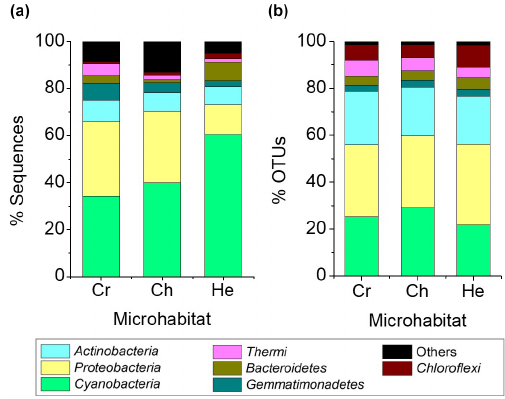
Figure 4. Average relative abundance of sequence reads (a) and OTUs at the 97% clustering cut-off (b) of major bacterial phyla (at least 1% across all samples) of microbial assemblages in the cryptoendolithic (CR) chasmoendolithic (CH) and hypoendolithic (HE) microhabitats of